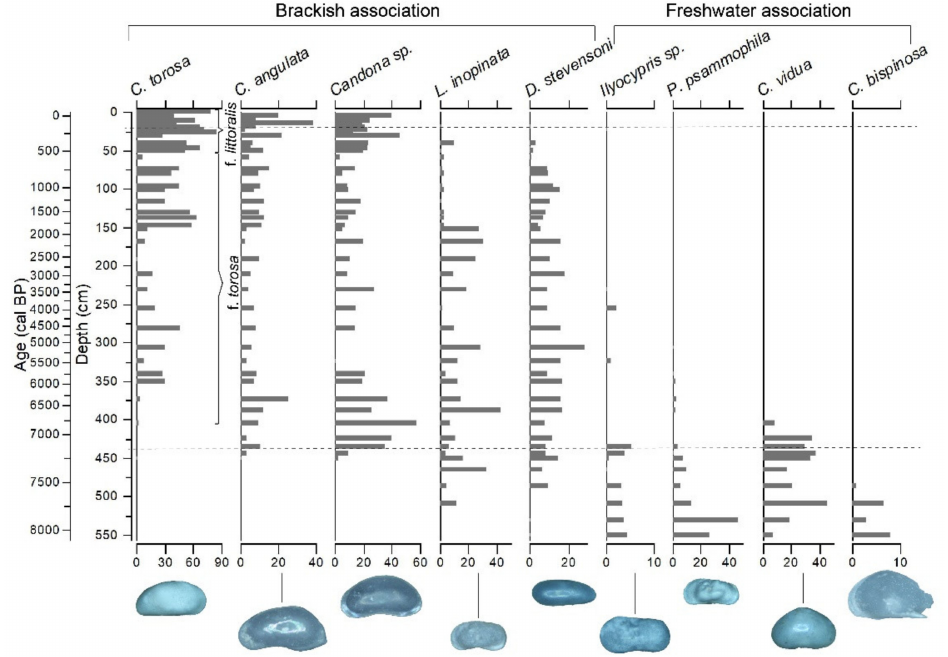
Figure 10. Relative distribution (%) of selected ostracod species in the sediment core from Velo Blato, with their photographs. Three general zones are marked by horizontal dashed